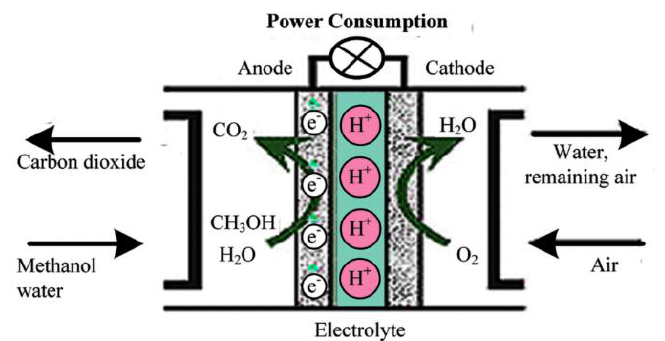
Figure 67. Schematic diagram of direct methanol fuel cells (DMFC); it uses a polymer electrolyte; instead of supplying hydrogen, methanol is fed to anode directly and the anode catalyst itself extract hydrogen from methanol [209].